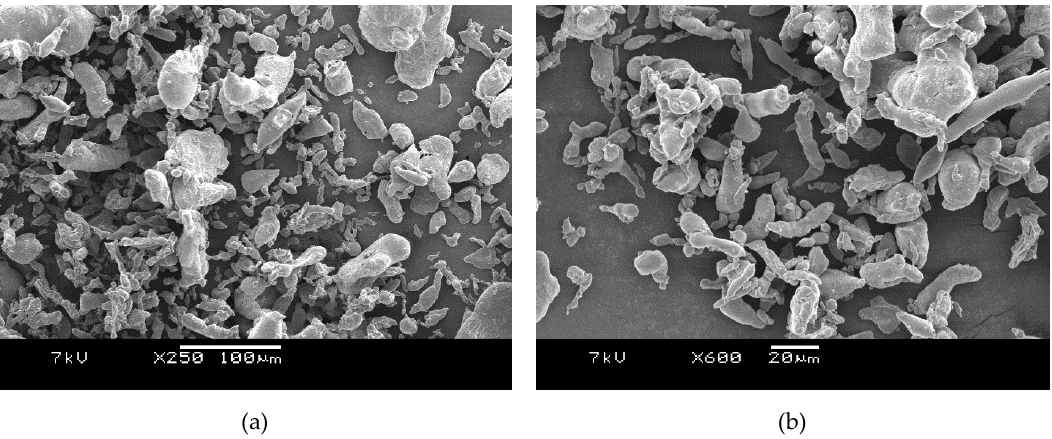
Figure 1. SEM images of ( a ) Al 1 micro-powders (250 × Magnification) showed bigger particle sizes than in the manufacturer’s data sheet in ( b ) Al 2, nominally nano powders (600 × Magnification) also showed much bigger particle sizes than in the manufacturer’s data sheet.